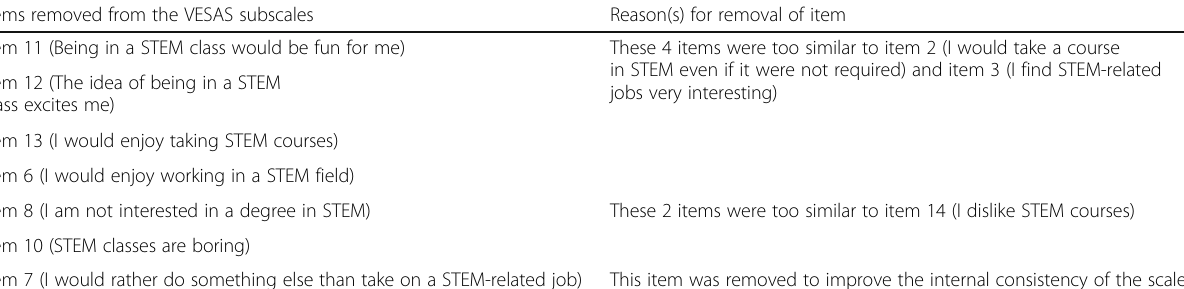
Table 2 Items that were removed from the VESAS subscales and their rationale for doing so Items removed from the VESAS subscales